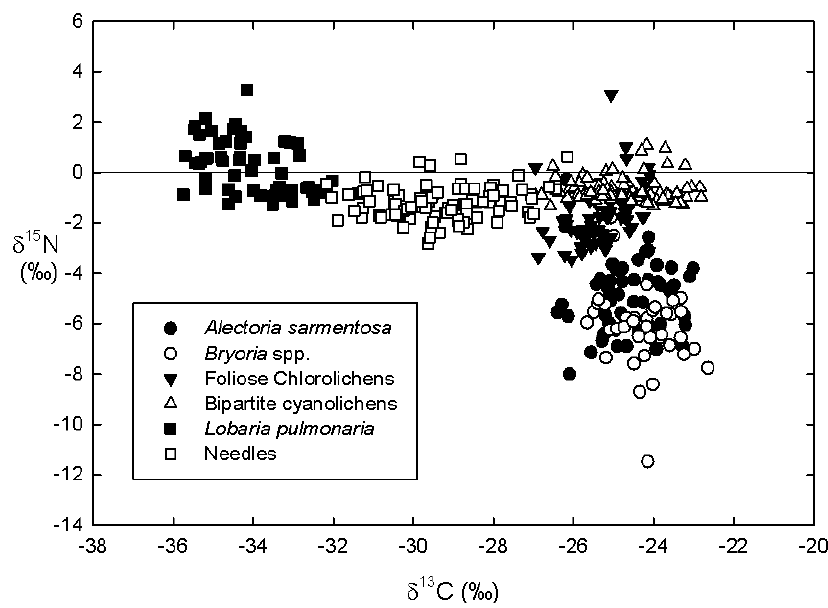
Figure 6. Dual natural abundance isotope plot of δ 15 N versus δ 13 C of the five epiphytic lichen functional group and host tree foliage (needle) biomasses across four sites and two host tree species.